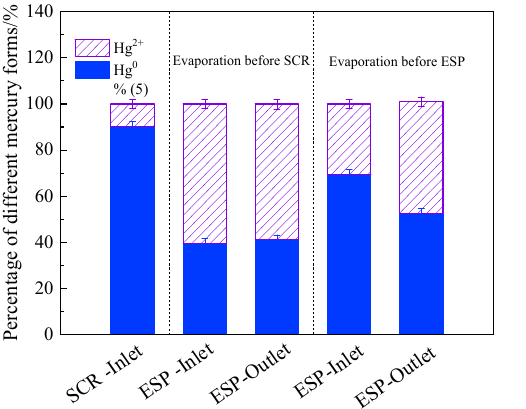
Figure 9. Influence of desulfurization wastewater evaporation on Hg speciation distribution in ESP.